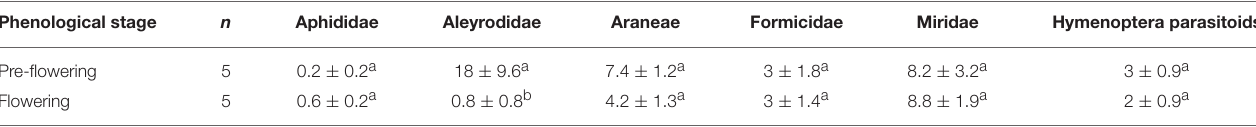
TABLE 3 | Average number (mean ± SE) of individuals of different taxonomic groups captured during the pre-flowering and flowering stages of D. viscosa bordering olive groves. Phenological stage n Aphididae Araneae Miridae Pre-flowering Flowering The letters representing superindices indicate differences between the flowering stages for each taxonomic group.